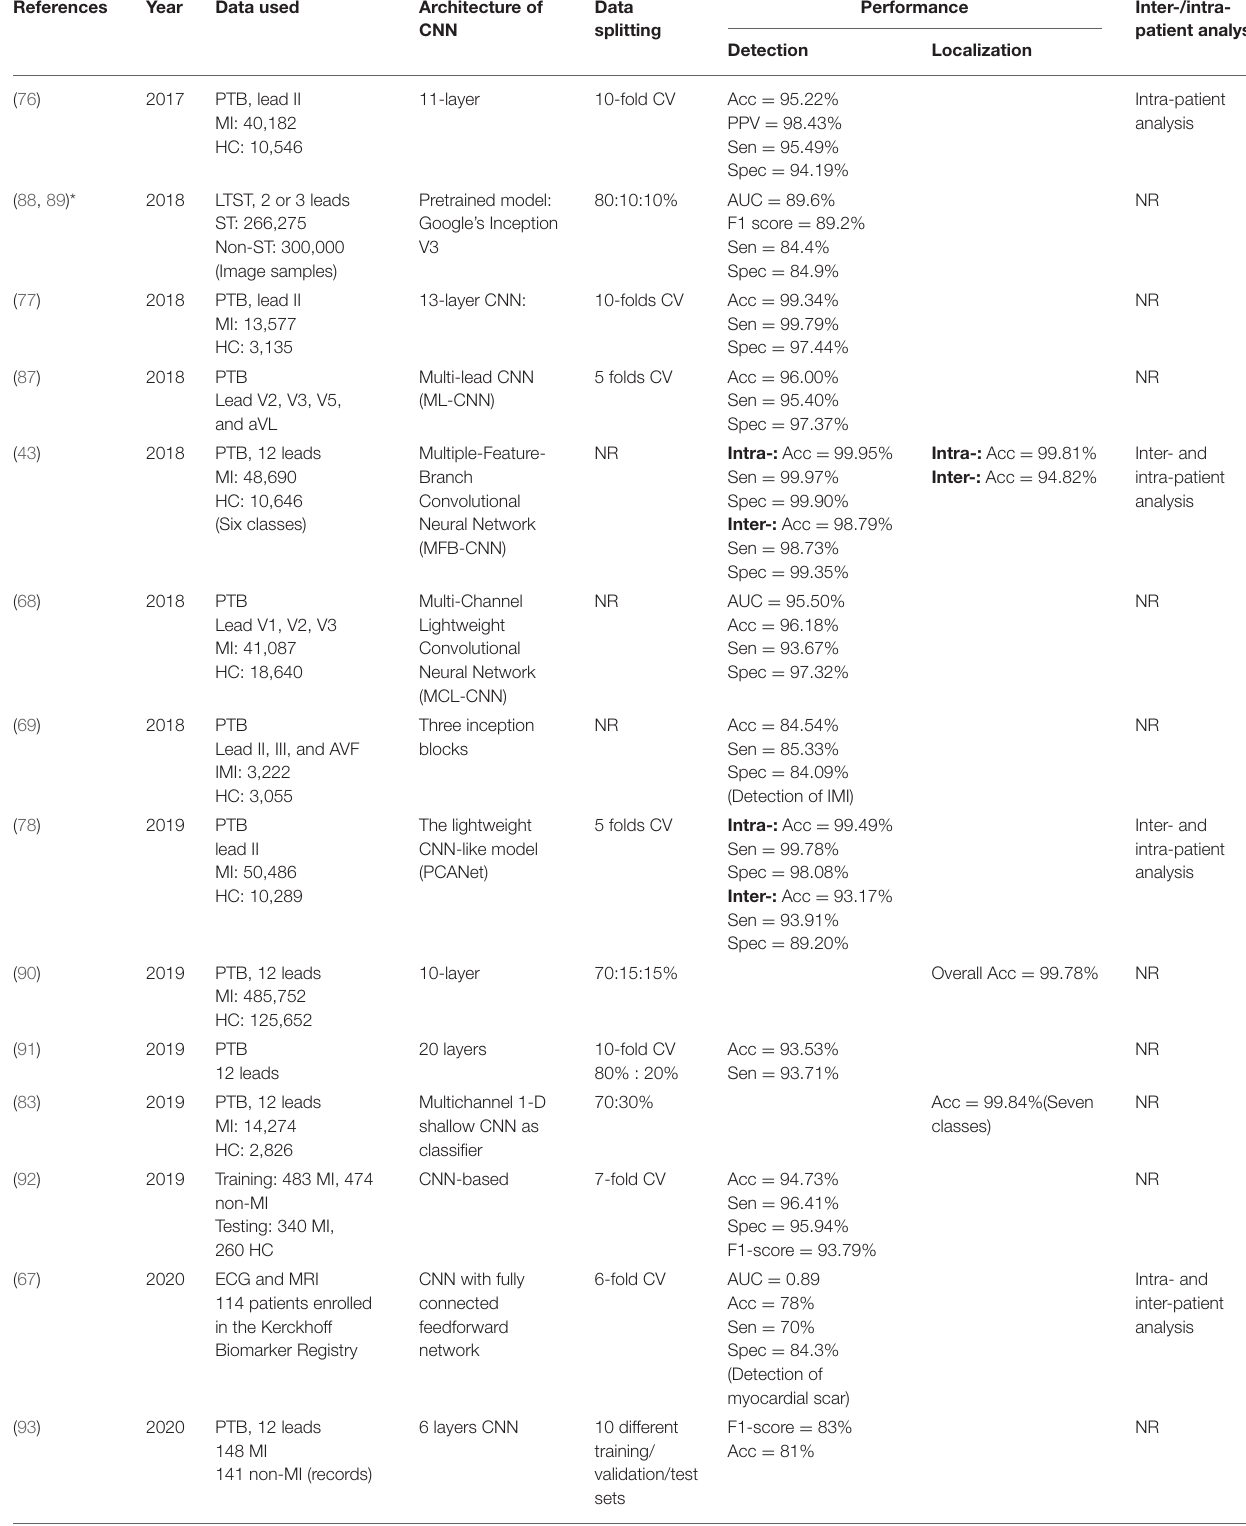
TABLE 4 | Properties of some notable convolutional neural network (CNN)-based ECG MI detection and